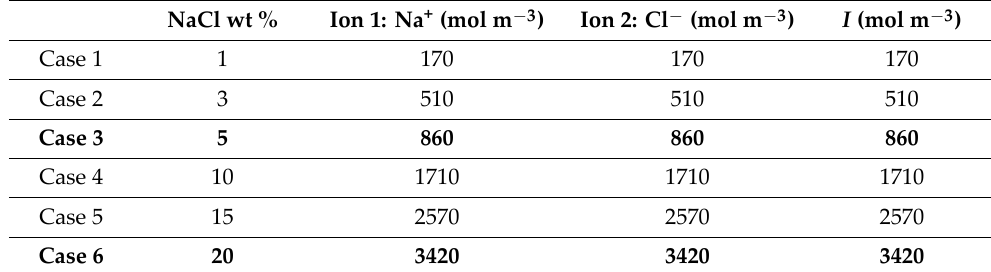
− 3 (mol dm ) for six cases studied i , ext